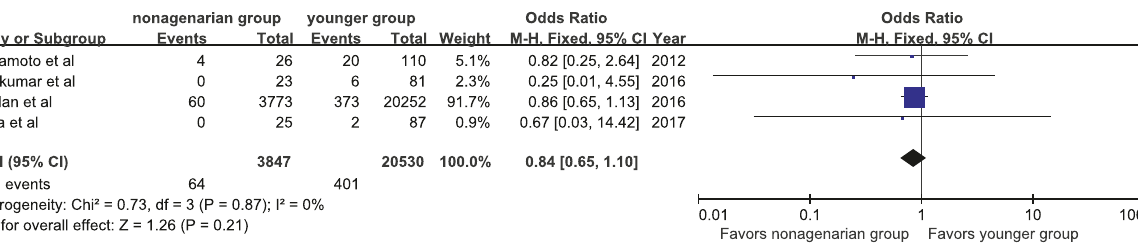
Figure 10: Forest plot of pooled analysis comparing the rates of stage 2 or 3 acute kidney injury in nonagenarians versus younger